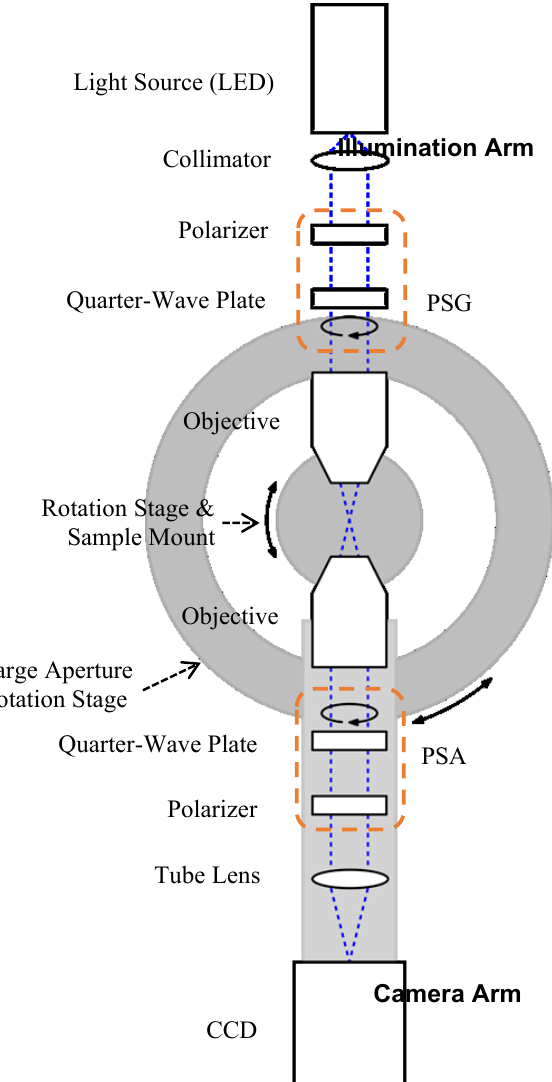
Fig. 1. Schematic representation of the Mueller matrix microscope